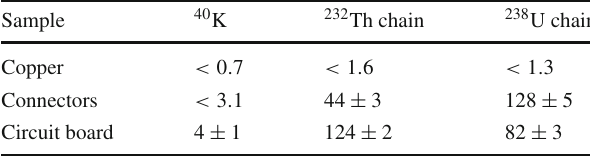
Table 1 Results of the screening measurement